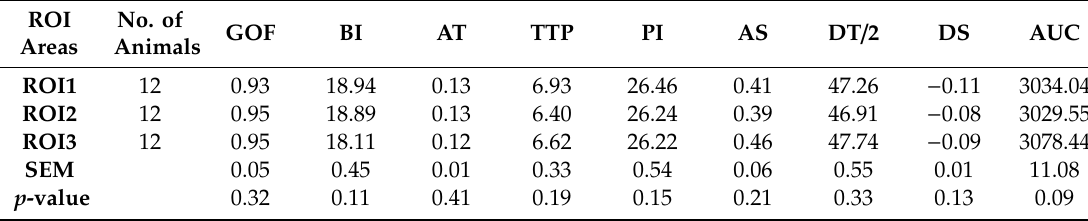
Figure 3. Contrast-enhanced images of the uterus. After 10–12 s hyperplastic endometrial layer showed ( left ) an avid enhancement with tortuous pattern due to presence of cysts and intraluminal material. ( right ) When uterine lumen is filled with material, very large cysts are surrounded by vascularized tissue. Table 1. Results from ANOVA for quantitative contrast-enhanced ultrasound (CEUS) parameters in relations to ROI* areas (mean values).